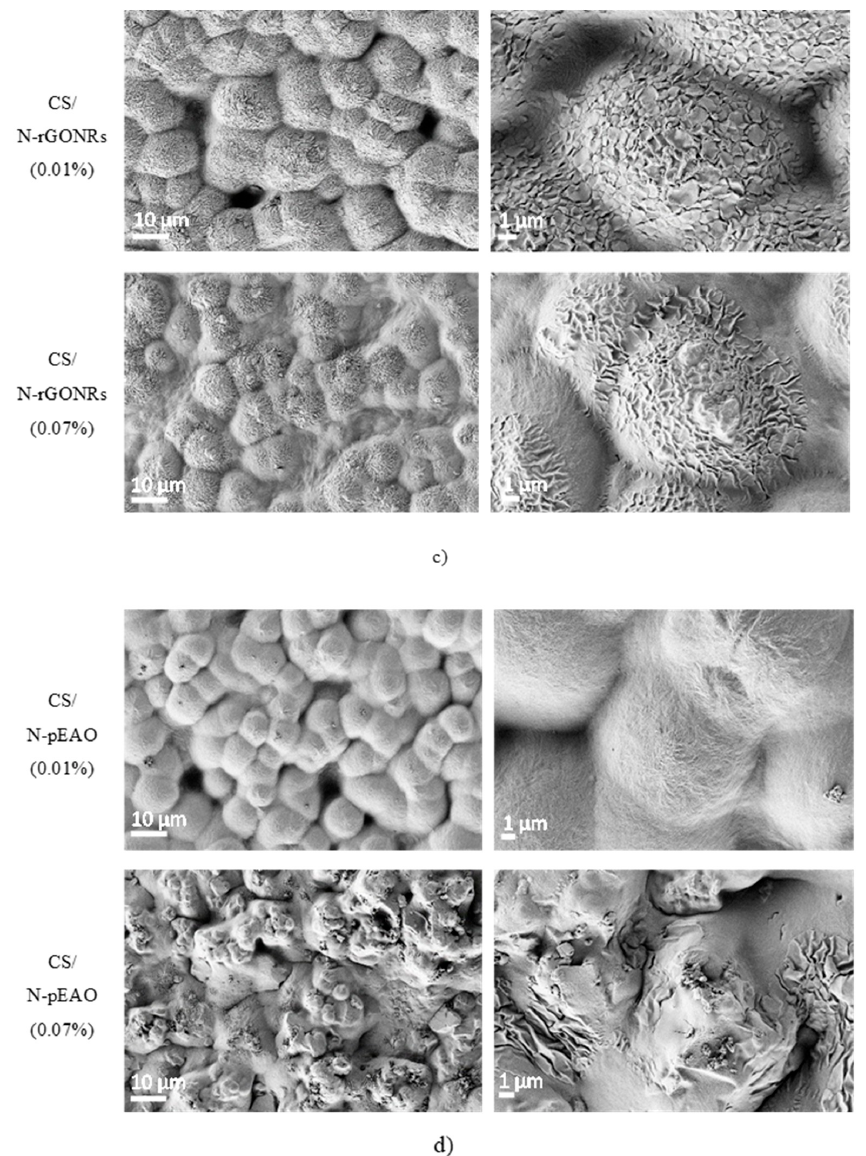
Figure 5. SEM images of ( a ) chitosan (CS) and CS/graphene ‐ based composites, containing 0.01% and 0.07% of ( b ) N ‐ rGO, ( c ) N ‐ rGONRs, and ( d ) N ‐ pEAO.